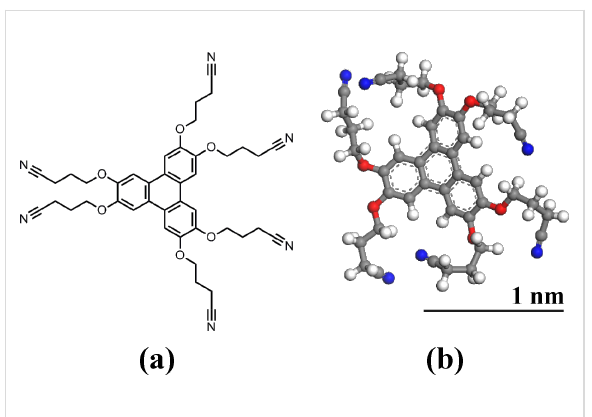
Figure 1: (a) Molecular scheme and (b) structure of HCPTP optimized in vacuum.